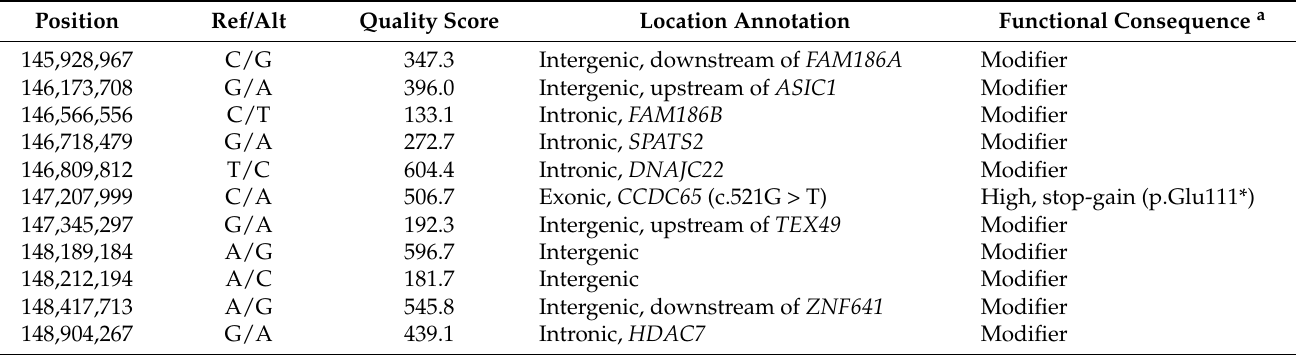
Table 1. Candidate SNPs, locations and functional annotations.